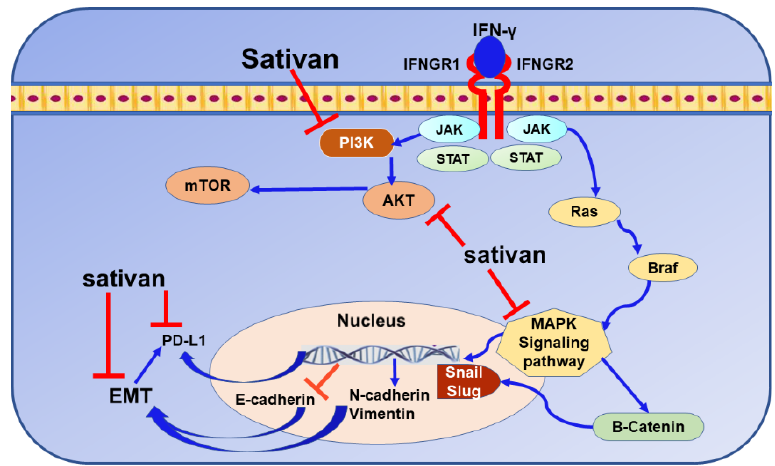
Figure 7. The mechanisms of sativan-mediated programmed death-ligand 1 (PD-L1) inhibition in breast cancer cells. Signal transducer and activator of transcription, STAT; Janus kinase, JAK; Phosphoinositide 3-kinase, PI3K; protein kinase B, AKT; mammalian target of rapamycin, mTOR; mitogen-activated protein kinase, MAPK; B-Raf Serine/Threonine-Protein, BRAF; rat sarcoma, Ras; interferon-gamma, IFN- γ ; IFN- γ receptor 1/2, IFNGR1/2; Snail family transcriptional repressor, Snail; Epithelial-to-Mesenchymal Transition, EMT.